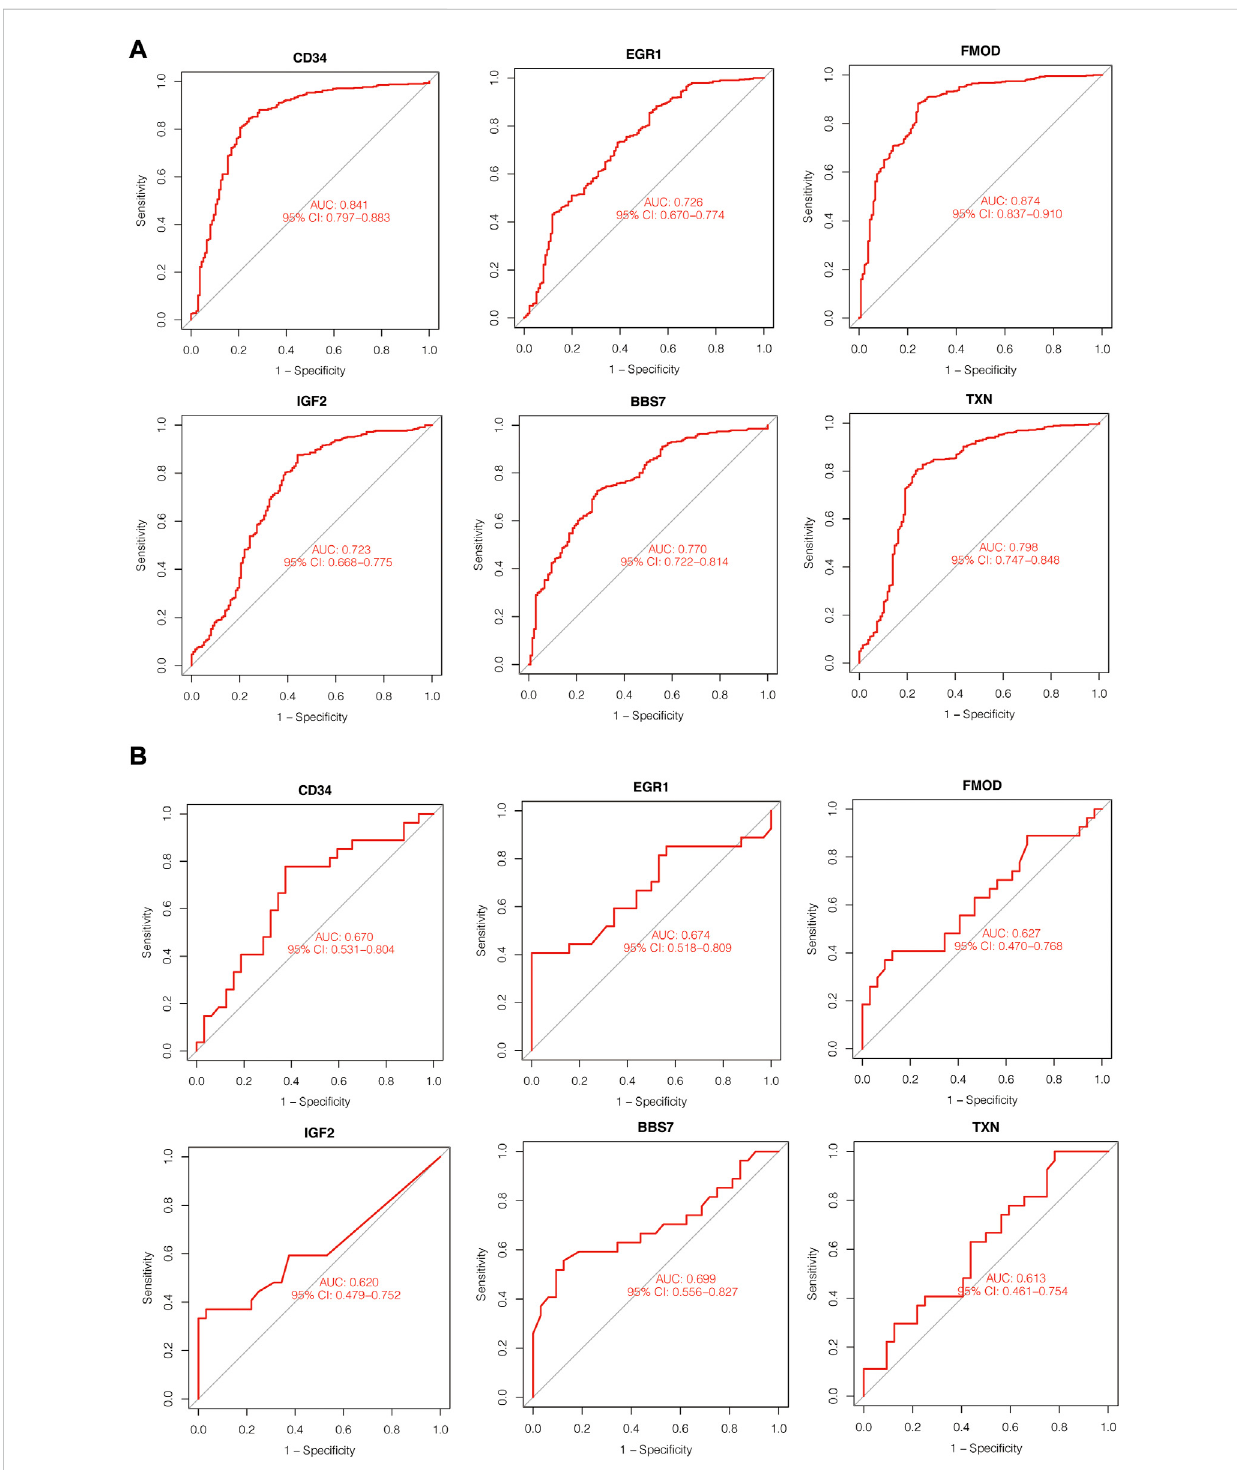
FIGURE 7 ROC curve of hub genes expression value in PD (A) and T1D (B)